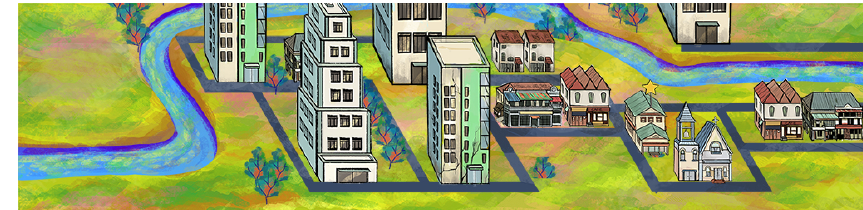
Figure 10. Example of an urban location in the game, Pyro City, with painted background and overlaid props.